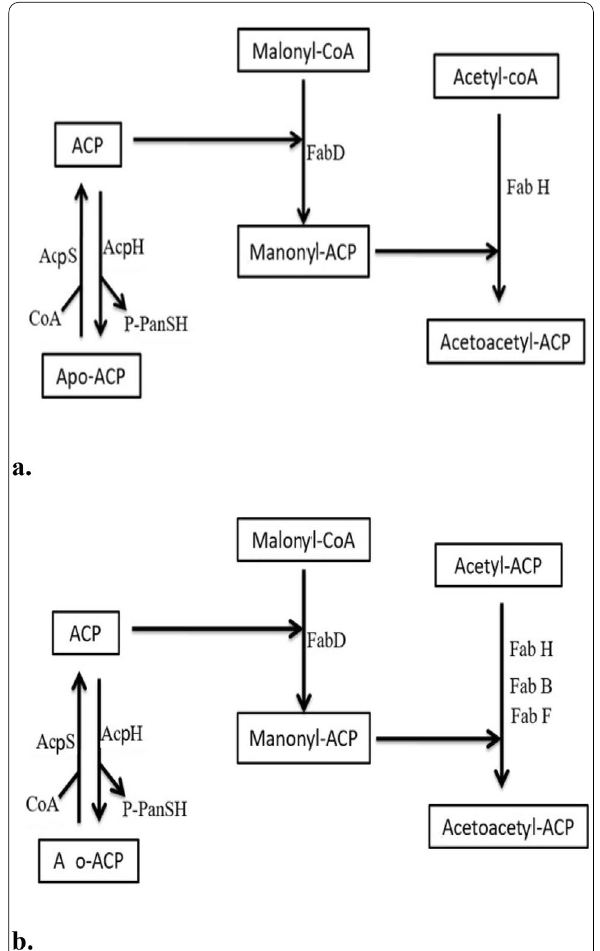
Fig. 2 Initiation steps ( a & b ) in the type II fatty acid synthesis pathway of